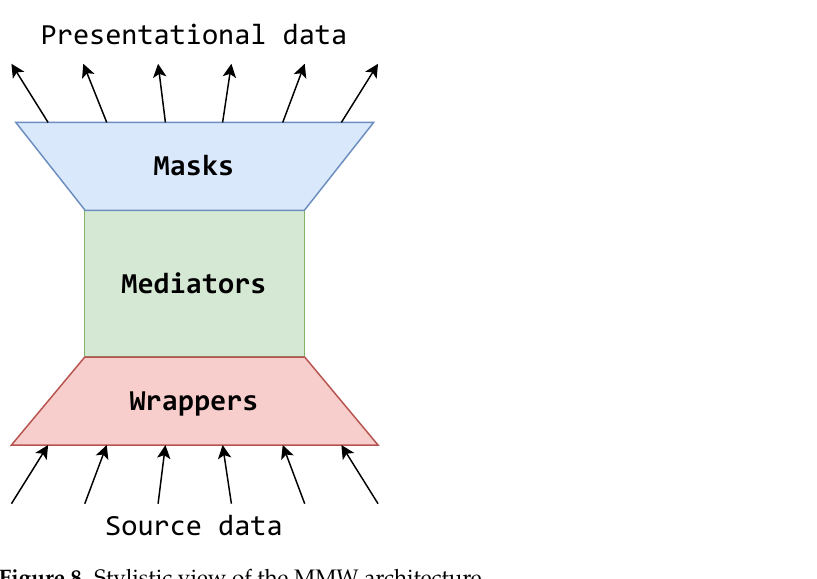
Figure 8. Stylistic view of the MMW